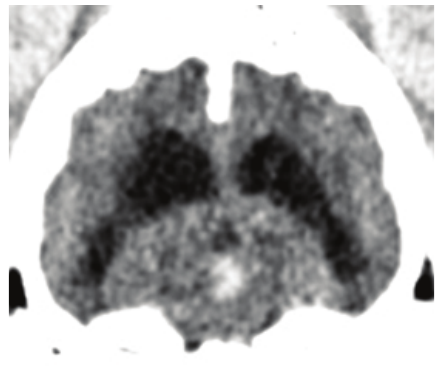
Figure 1: Transverse CT image of the brain prior to contrast medium administration showing a small intra-axial hyperatten- uating lesion in the mesencephalon and a moderate asymmetric enlargement of the ventricular system.